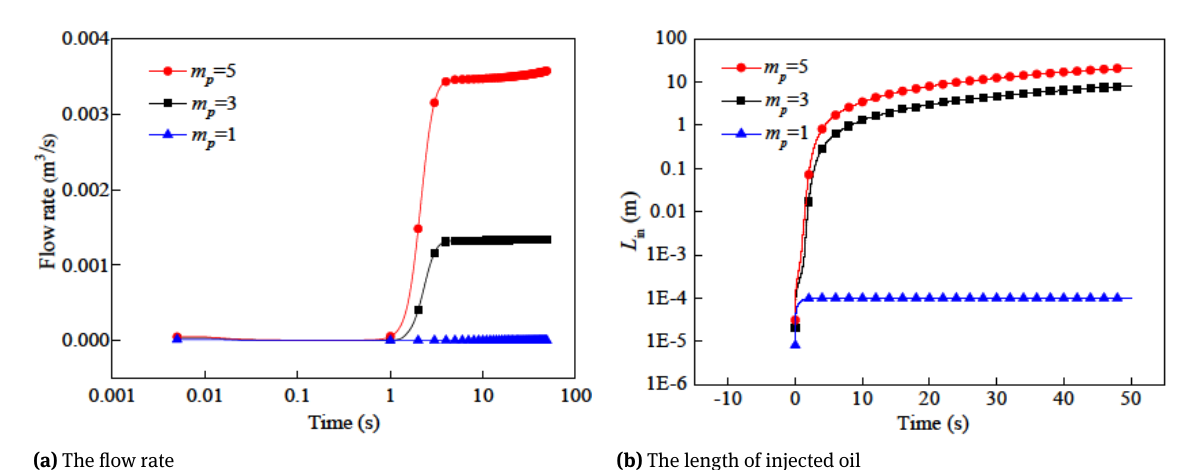
Figure 13: The flow rate and length of injected oil of Model 2